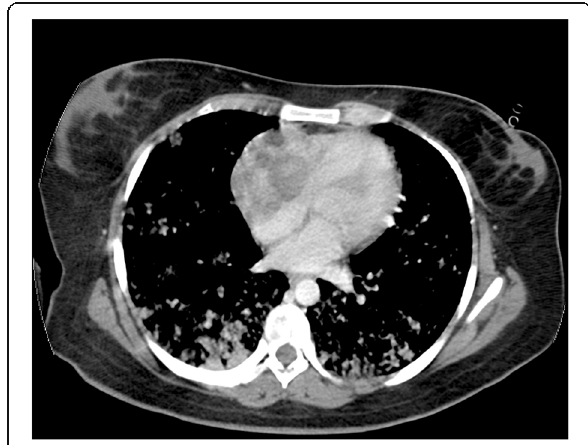
Fig. 1 Axial computed tomography scan of the thorax in the mediastinal window demonstrating lesion centered in the right atrium, infiltrating the